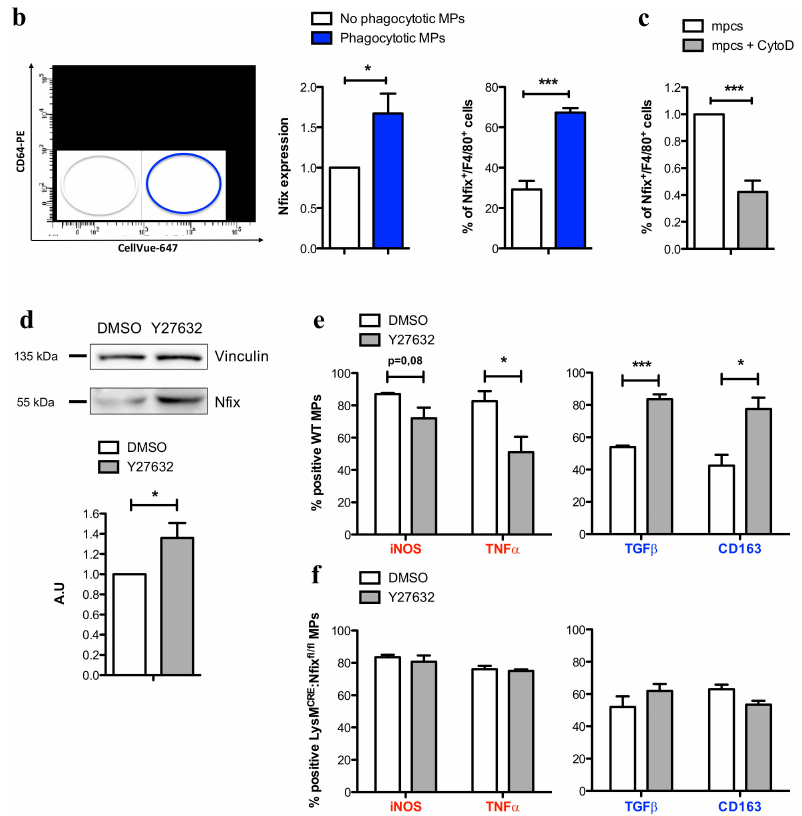
Figure 5. Nfix is expressed after phagocytosis and drive MP phenotypical switch. ( a ) Phagocytosis assay of M1 and M2c Nfix fl / fl and LysM CRE :Nfix fl / fl MPs cocultured 8h with apoptotic mpc. Representative FACS gate of phagocytotic M2c Nfix fl / fl and LysM CRE :Nfix fl / fl MPs (CD64 + CellVue + ) and percentage of phagocytotic M1 and M2c MPs coming from Nfix fl / fl and LysM CRE :Nfix fl / fl BMDM; ( b ) WT MPs were cocultured 16h with apoptotic mpcs. Representative FACS gate of non-phagocytotic (CD64 + CellVue − ) and phagocytotic (CD64 + CellVue + ) WT MPs. Quantification of Nfix expression realized by RT-qPCR on sorted non-phagocytotic and phagocytotic WT MPs and quantification of MPs positive for Nfix (Nfix + / F4 / 80 + ) realized by IF on non-phagocytotic and phagocytotic WT MPs; ( c ) WT MPs were cocultured for 16 h with apoptotic mpcs, with or without addition of Cytochalasin D. Quantification of F4 / 80 + MPs were positive for Nfix on a total of F4 / 80 + MPs; ( d ) Western blot of Nfix expression in WT MPs treated with DMSO (Dimethyl sulfoxide) or Y27632 for 16 h and quantification. Vinculin was used to normalize; ( e ) WT MPs were treated with DMSO or Y27632 for 16 h and were immunolabeled for pro-inflammatory markers (iNOS and TNF α ) and anti-inflammatory markers (TGF β and CD163). The number of positive cells is expressed as percentage out of total cells; ( f ) LysM CRE :Nfix fl / fl MPs were treated with DMSO or Y27632 for 16 h and were immunolabeled for pro-inflammatory markers (iNOS and TNF α ) and anti-inflammatory markers (TGF β and CD163). The number of positive cells is expressed as percentage out of total cells. * p < 0.05, *** p < 0.001. Results are means ± SEM of at